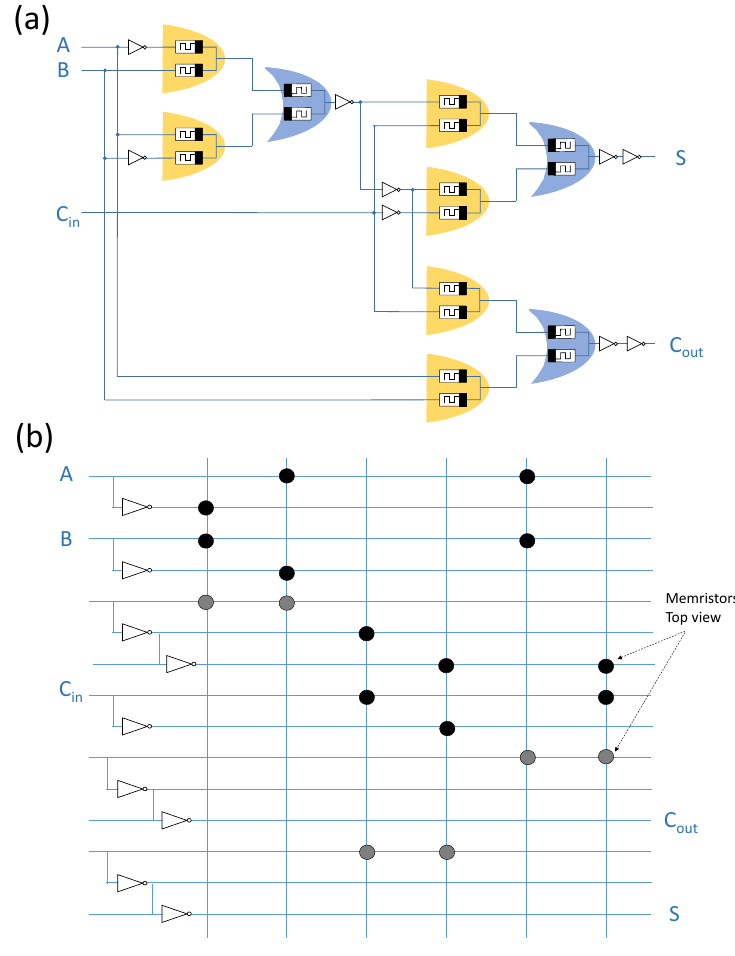
Figure 8. One-Bit Full Adder based on the proposed X-MRL structure. Reproduced with permission from [12], Copyright 2019,